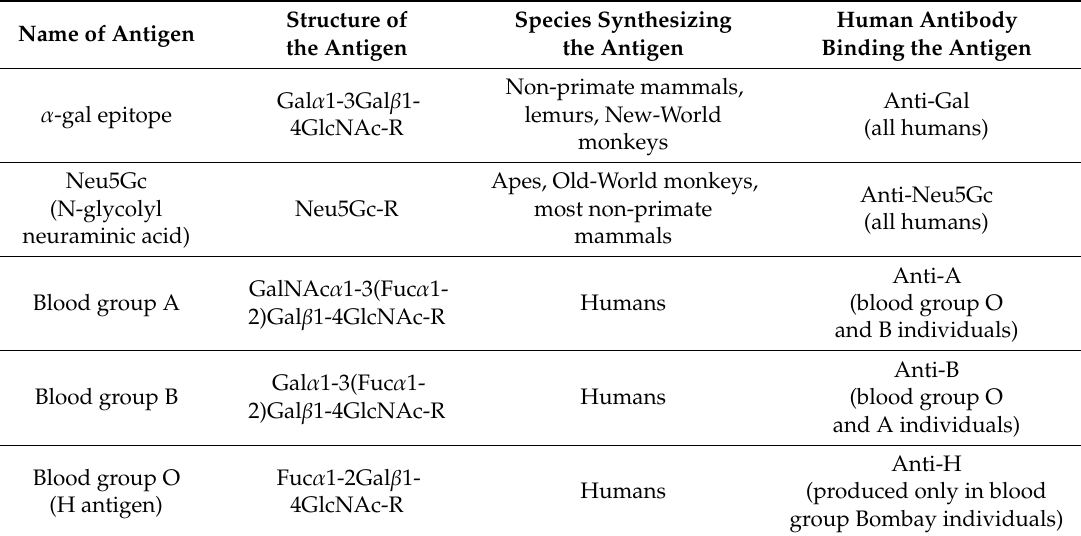
Table 1. Carbohydrate antigens on virus glycan shield recognized by human natural antibodies.